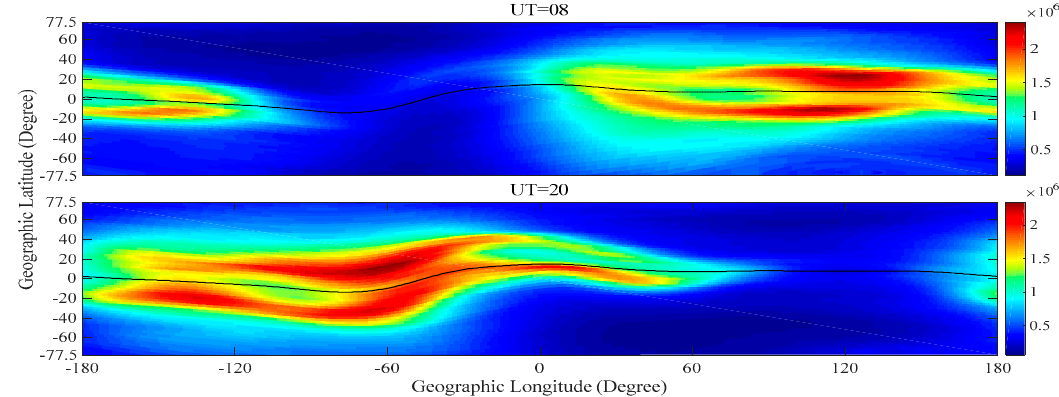
Figure 11. Global distributions of NPPDM NmF2 (cm − 3 ) at the September equinox under middle (F10.7 = 120 sfu) solar activity.